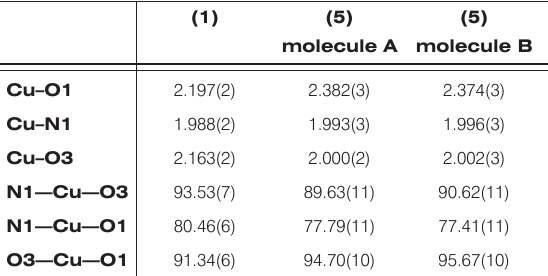
Table 3. Selected bond lengths and hydrogen bond parameters (Å, °) for ( 1 ) and ( 5